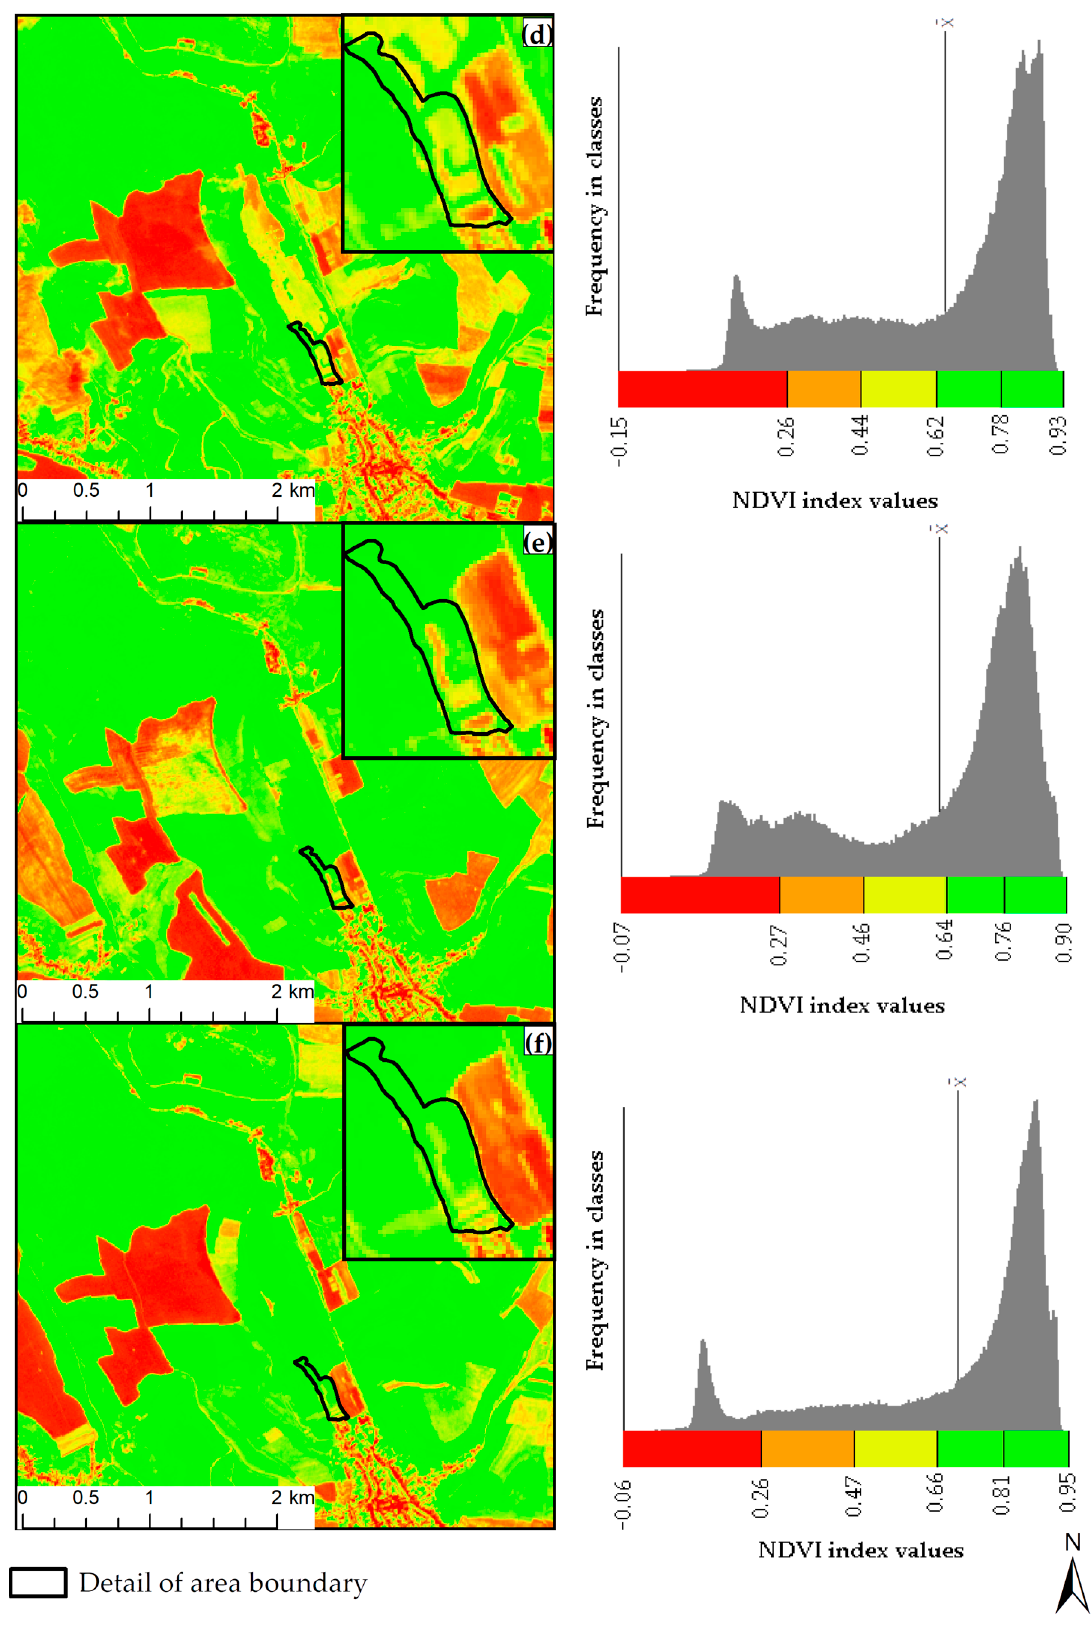
Figure 13. NDVI index: ( a ) 1998; ( b ) 2016; ( c ) 2017; ( d ) 2018; ( e ) 2019; ( f ) 2020.